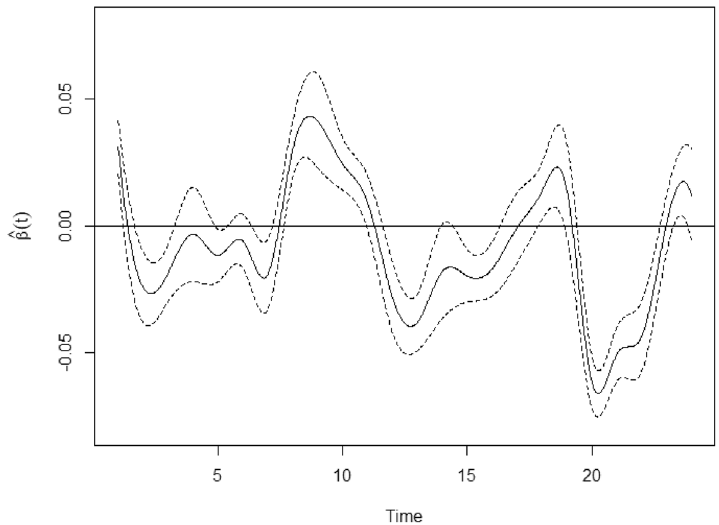
Figure 3. Regression coefficient function ˆ β( t ) and its 95% confidence